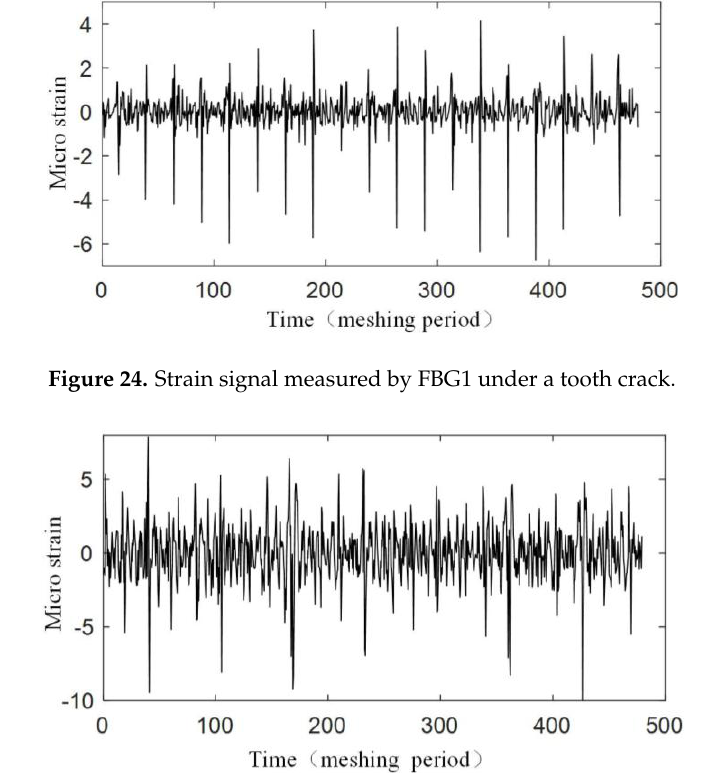
Figure 25. Strain signal measured by FBG2 under a tooth crack.